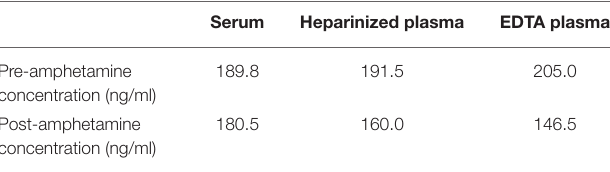
TABLE 1 | Mean amphetamine values in a dog with suspected amphetamine poisoning before and after IVLE